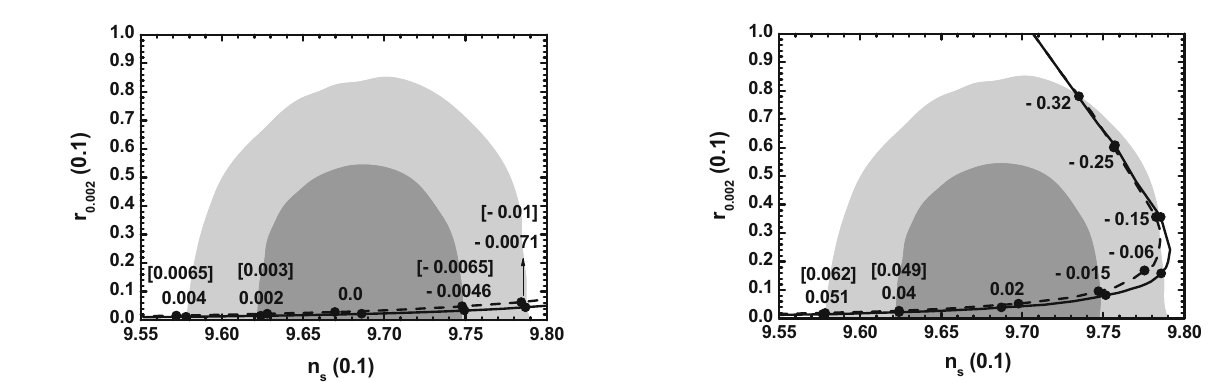
Fig. 1 Allowed curves in the n s − r 0 . 002 plane for K = K 1 R (dashed line) and K = K 2 R (solid line) – the n values in [outside] squared brackets correspond to K = K 1 R [ K = K 2 R ]. The marginalized joint 68% [95%] regions from Planck , BAO and BK14 data are depicted by the dark [light] shaded contours